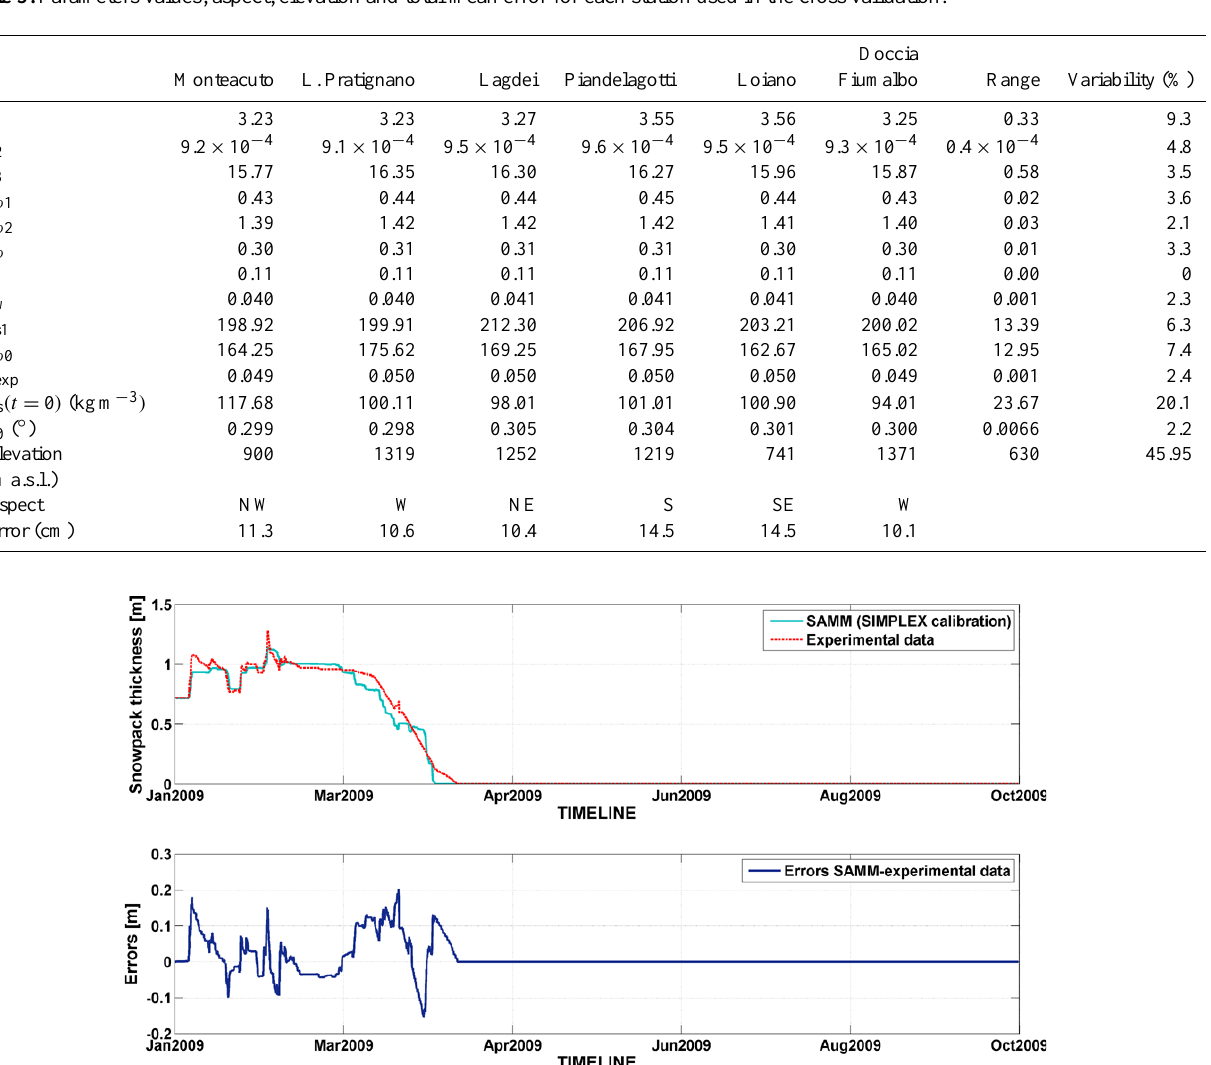
Table 3. Parameters values, aspect, elevation and total mean error for each station used in the cross validation.